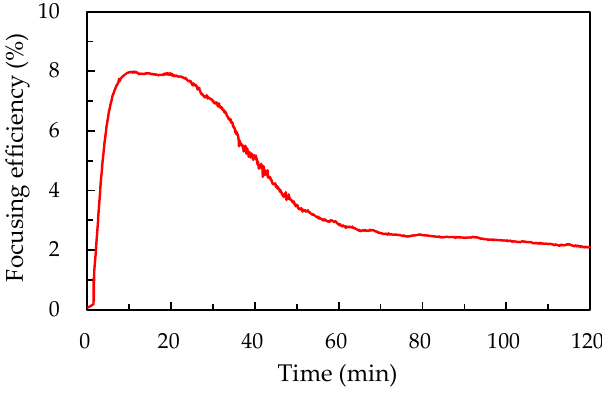
Figure 2. The focusing e ffi ciency of the ADDCLC sample as a function of the irradiation time by the pumping beam.